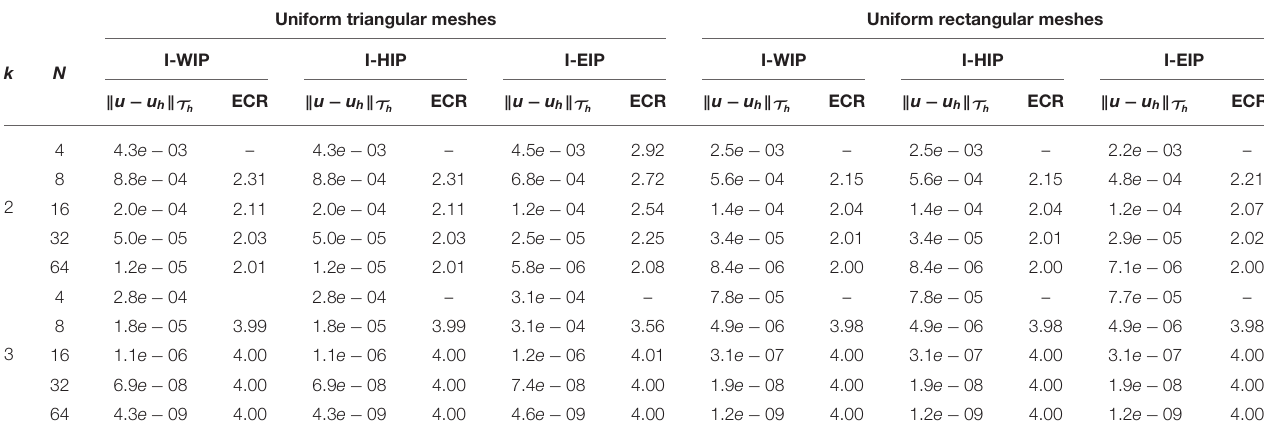
TABLE 2 | Homogeneous case. Uniform triangular meshes Uniform rectangular